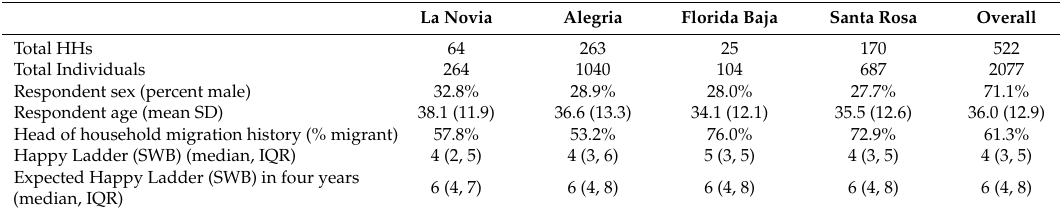
Table 2. Socio-demographic characteristics of survey